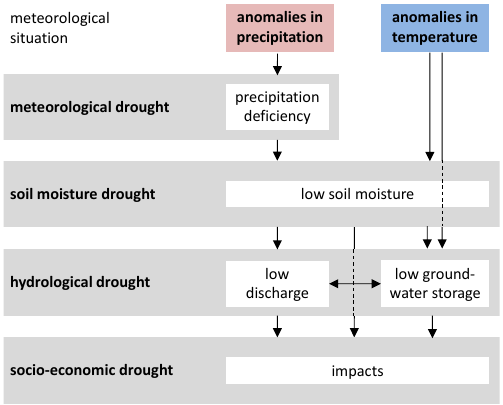
Figure 1. Scheme representing drought propagation (adapted from Fig. 8.1 of Van Loon, 2013).